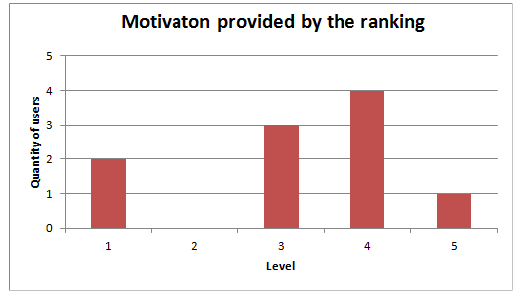
Figure 26. ViMeTGame evaluation question about the ranking . Scale: 1 to “Disagree”and 5 to “Fully